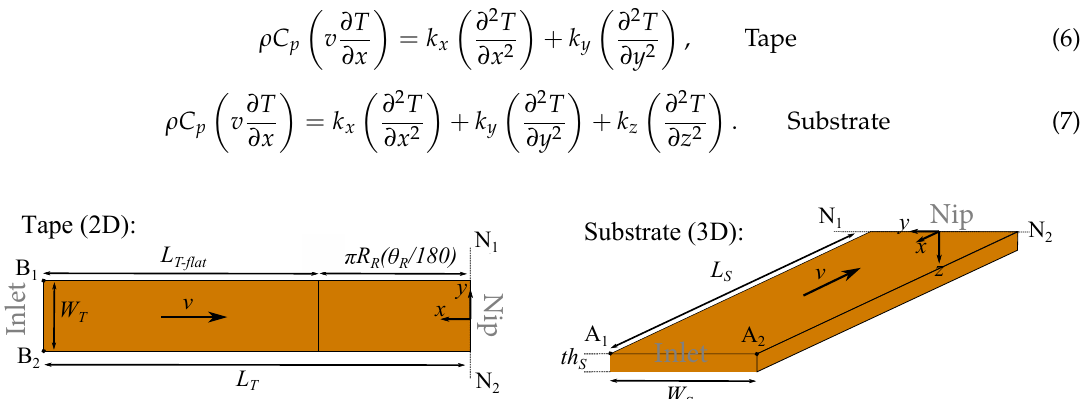
Figure 6. Schematic view of the thermal domains for tape and substrate which were unfolded from the optical domain defined in Figure